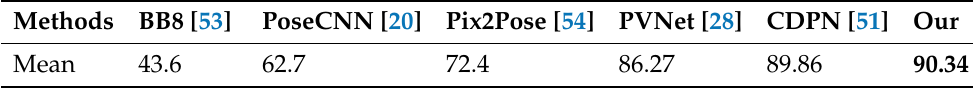
Table 3. Quantitative Evaluation on the Linemod Dataset.